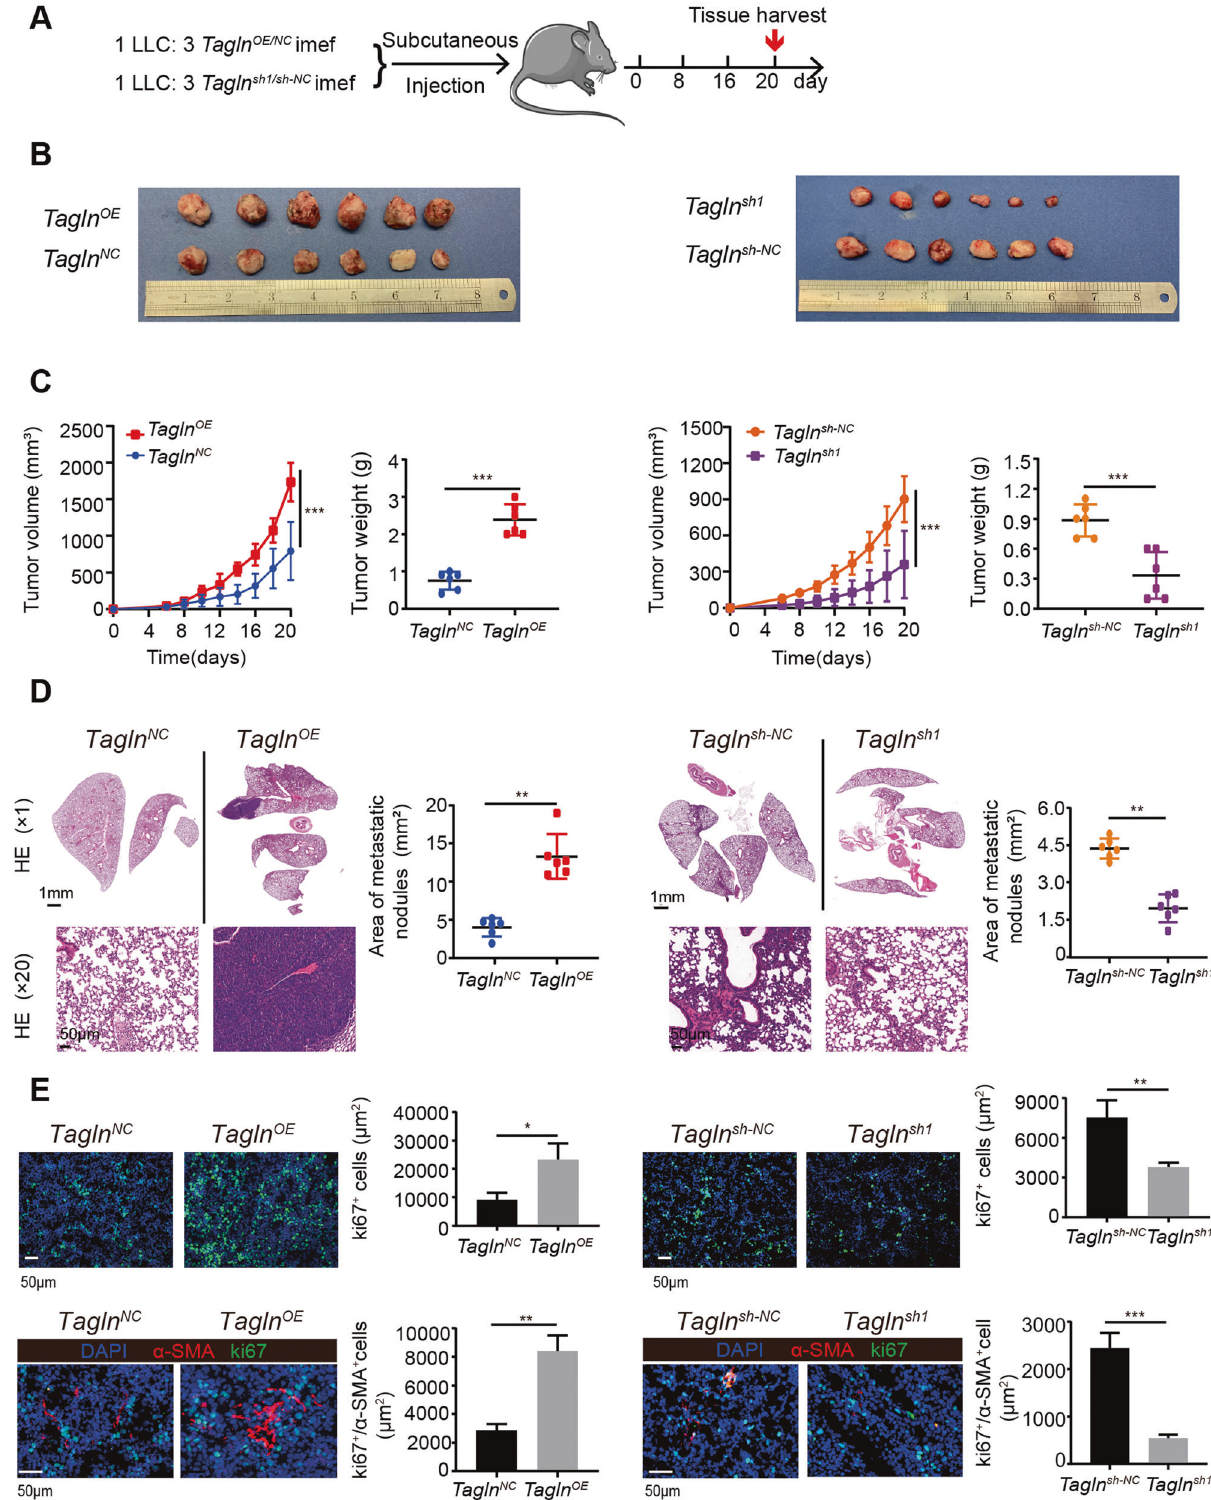
Fig. 5 Tagln OE fi broblasts promote the growth and spread of lung cancers. A Scheme of the mouse experiment design. B Images of the tumors from the different groups. C Tumor growth curves and weights ( n = 6); *** p < 0.001. D Representative hematoxylin and eosin staining images of lungs and areas of lung metastasis for each group. Upper panel scale bar: 1 mm; lower panel scale bar: 50 µm. Results are represented as mean ± SEM and compared by unpaired t -test. ** p < 0.01. E Immuno fl uorescence staining for Ki-67 (green) and nuclear staining DAPI (blue) of tumors from the different groups (upper panels). Immuno fl uorescence staining for α -SMA (red), Ki-67 (green), and nuclear staining DAPI (blue) of tumors from the different groups (lower panels). Quanti fi cation of co-expression of α -SMA + and Ki-67 + cells. Data are represented as mean ± SEM from at least three independent